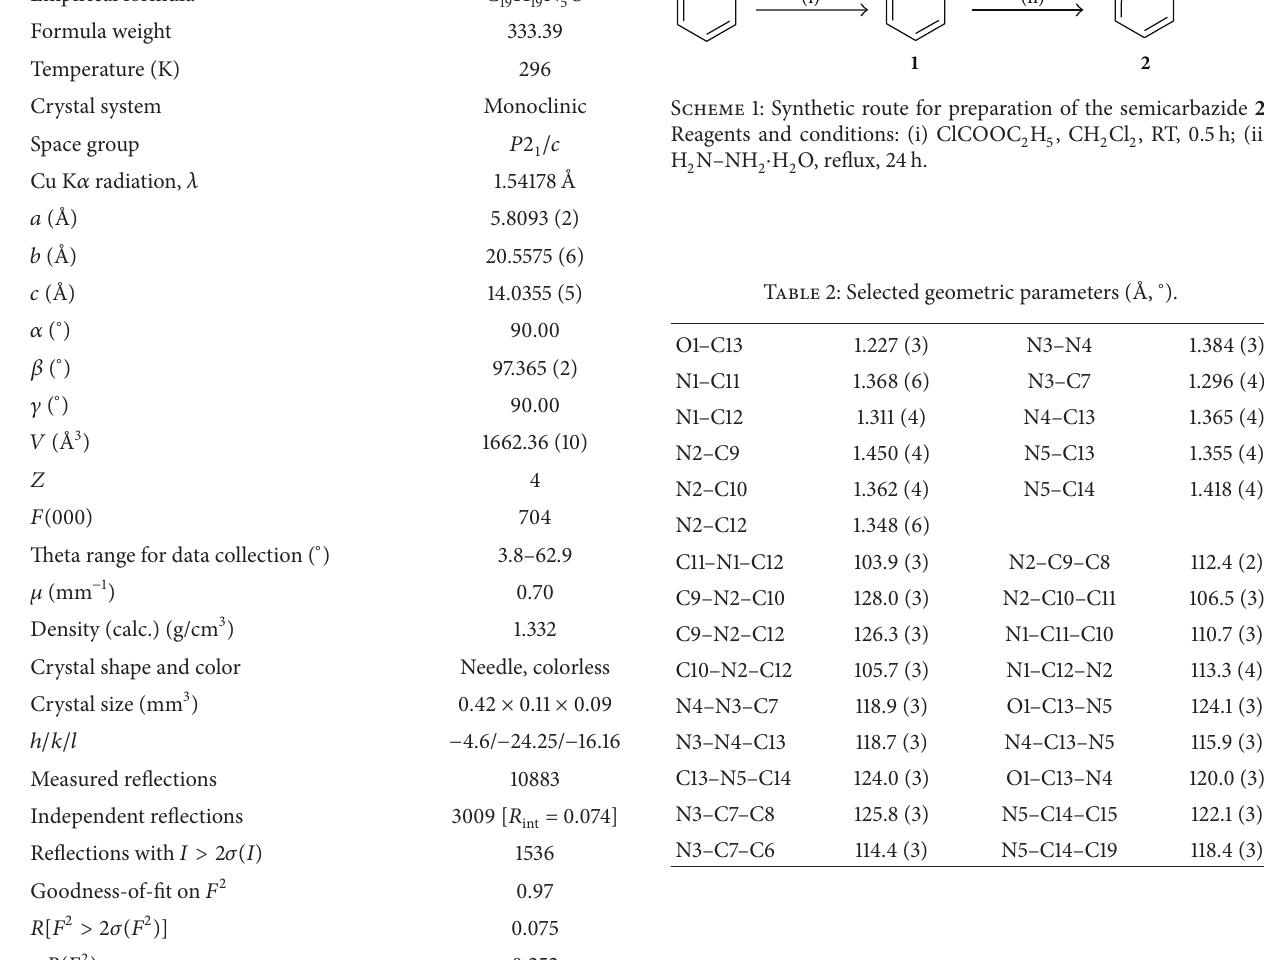
Table 3: Hydrogen-bond geometry (˚A, ∘